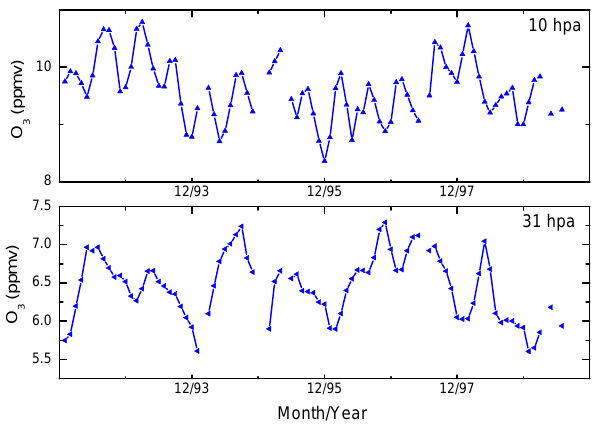
Fig. 1. Time series of zonal mean ozone volume mixing ratio over 0–10 ◦ N latitudinal band for the period January 1992–July 1999 at two representative pressure levels (10hPa and